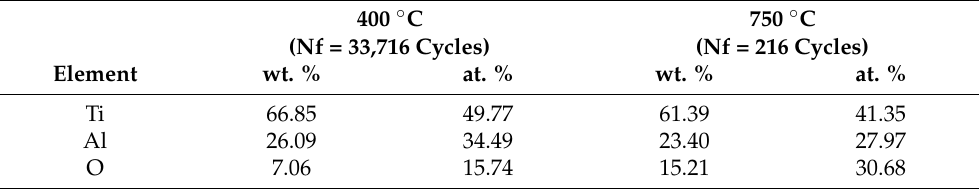
Table 3. EDS results of the element contents on the fracture of specimens at different tempera- tures.